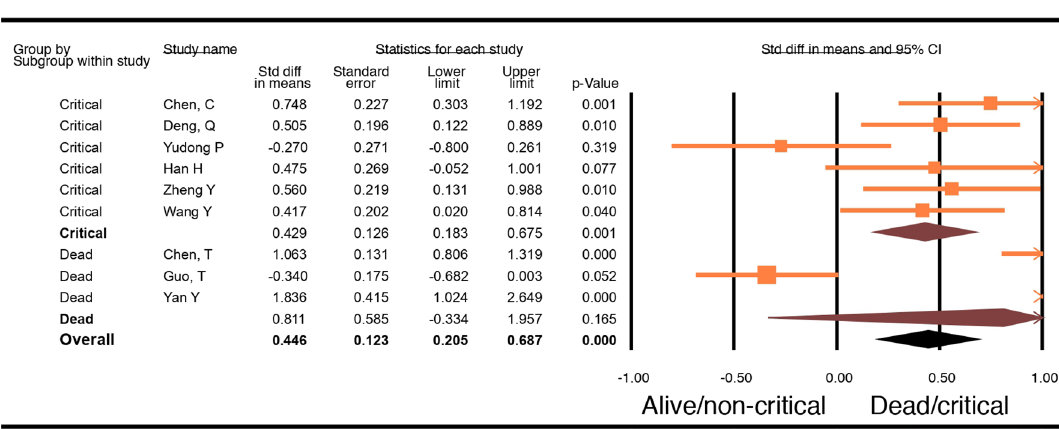
Figure 3. Forest plot of WMD in BNP between alive and/or not critically ill patients and dead and/or critically ill patients with